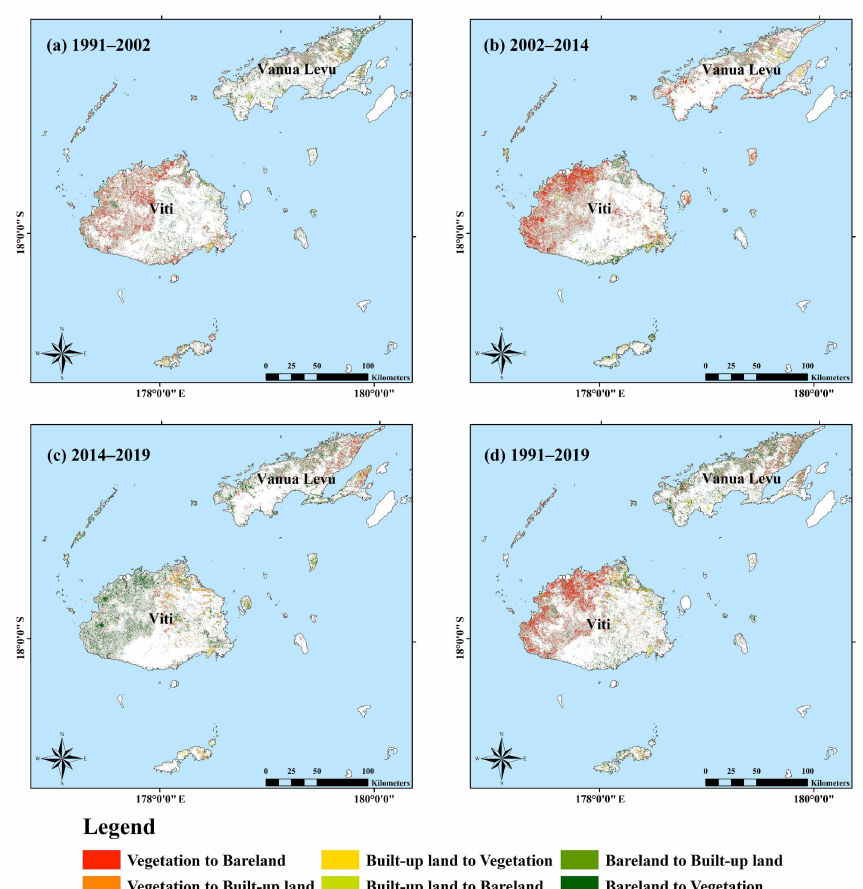
Figure 5. Dynamic changes in land-use types in Fiji’s land area: ( a ) 1991–2002; ( b )